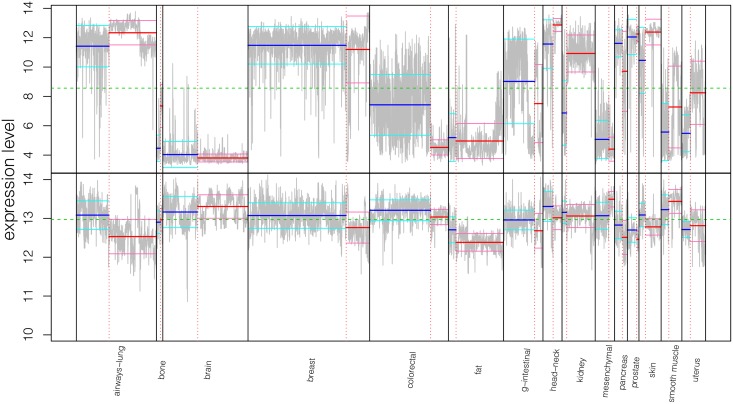
Extreme expression level profiles.Expression levels of the most variable probeset (202286_s_at), on top, and a low-variability probeset corresponding to housekeeping gene GAPDH (217398_x_at), at the bottom, across all tissues for which there are at least 20 replicates of untreated, normal and cancerous samples. Samples from the same tissue of origin are displayed together, grouped by disease status. The green dashed line represents the overall mean; blue and red solid lines show the mean of cancerous and normal groups, respectively, whereas cyan and pink solid lines describe their respective dispersion, given by the within group standard deviation.